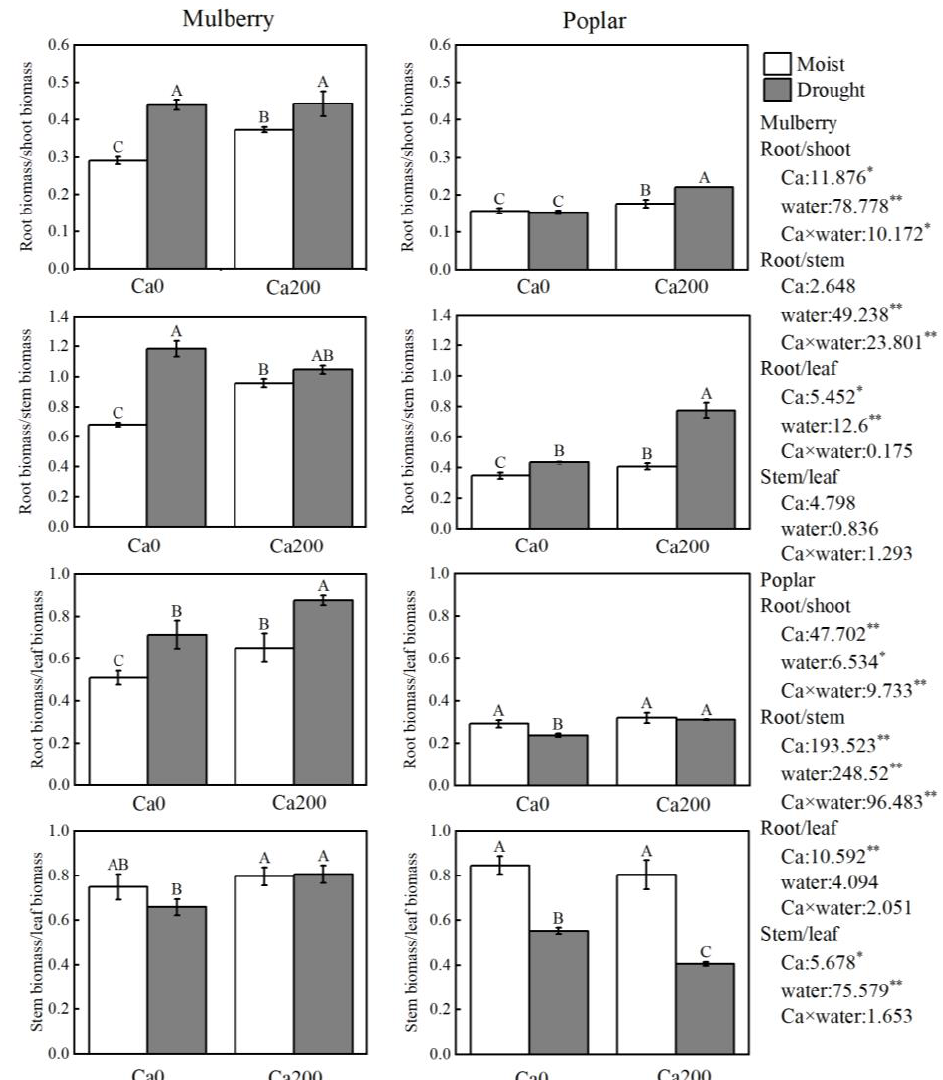
Figure 3. Effects of water and Ca treatments on biomass allocation of organs in the two species. Different letters indicate significant differences ( p < 0.05) among treatments. Treatment values shown as mean ± SE (n = 6). Results of two − way ANOVA addressing effects of Ca and water treatments are summarized on the right side. *, ** indicate that the F value is significant at p ≤ 0.05 and 0.01, respectively.